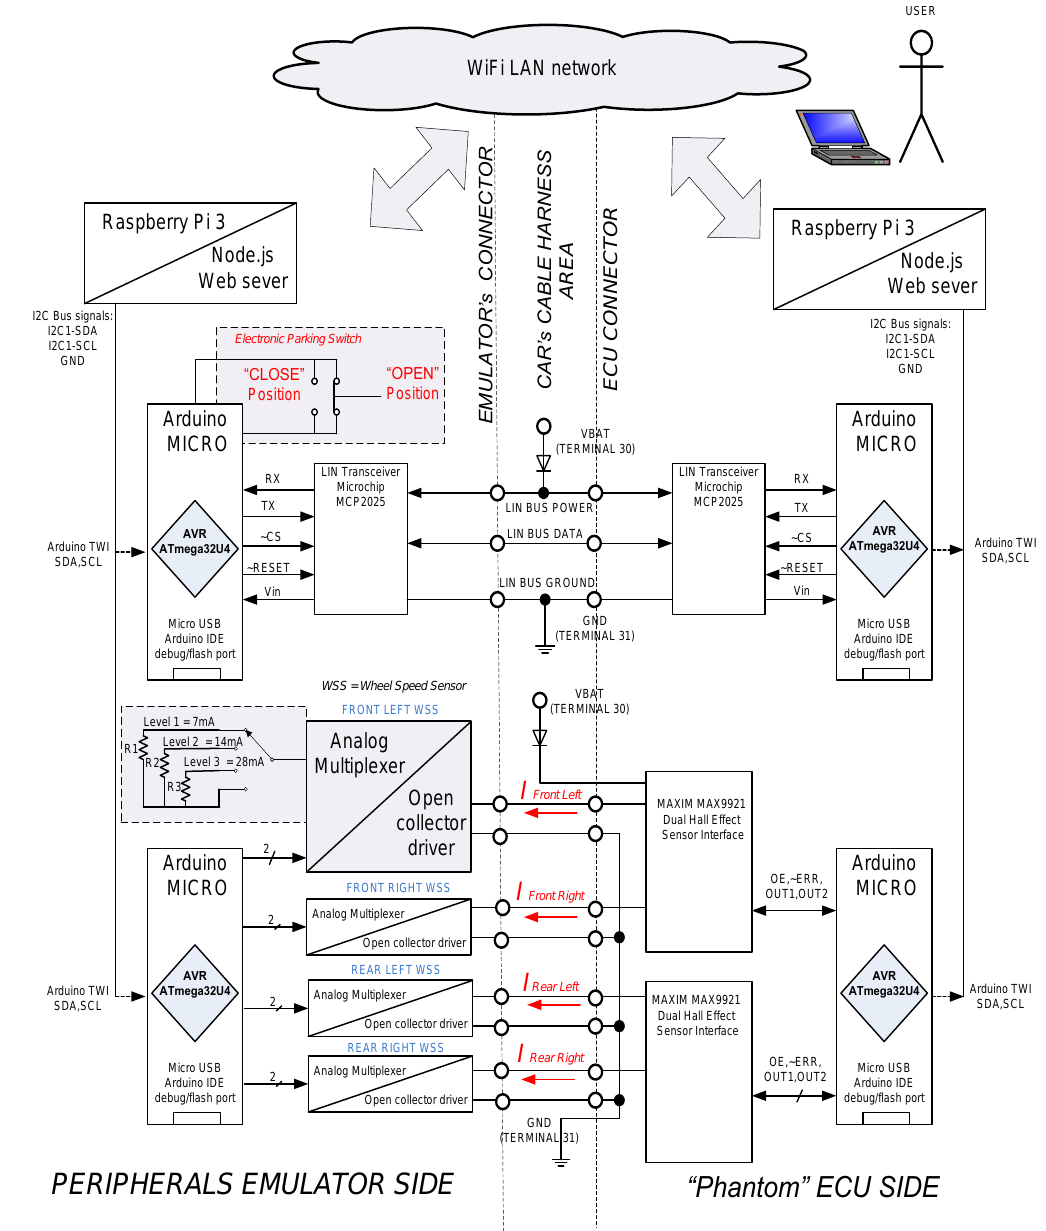
Figure 8 Blok diagram of the developed educational system for ECU peripheral's